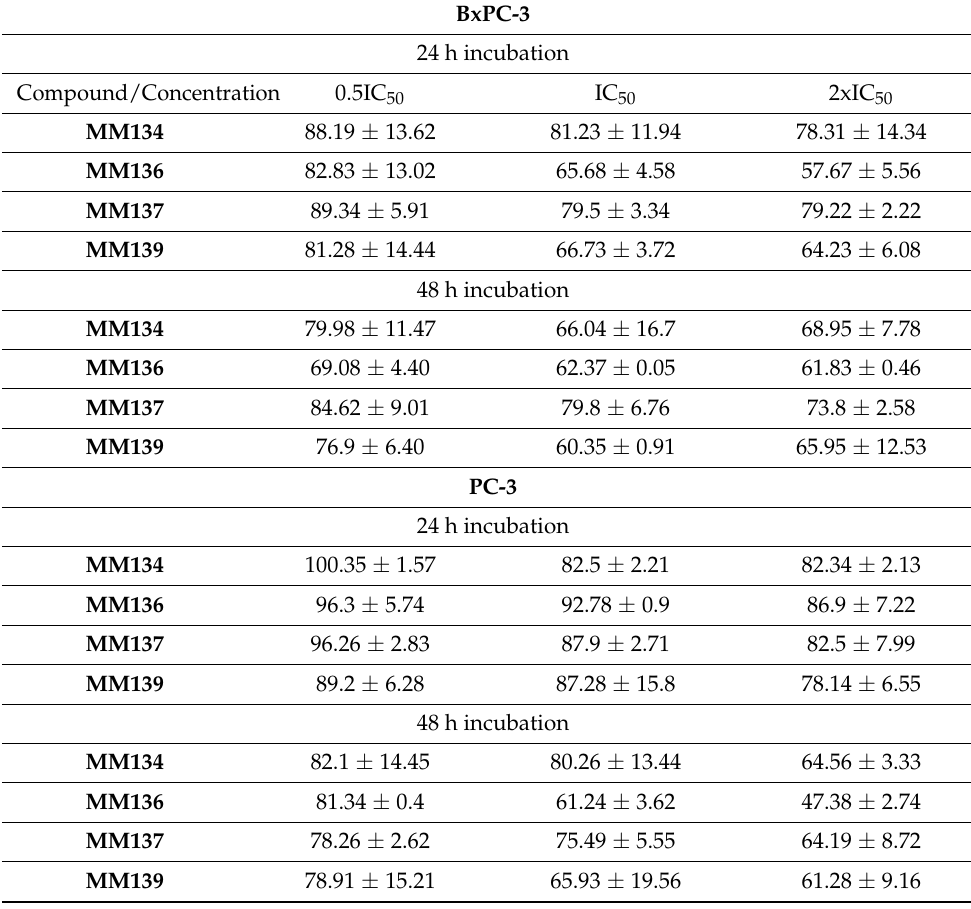
Table 2. Results of MitoTracker Red analysis in tested cancer cell lines. Data for individual compounds are presented as mean percentage of control group fluorescence intensity ± SD